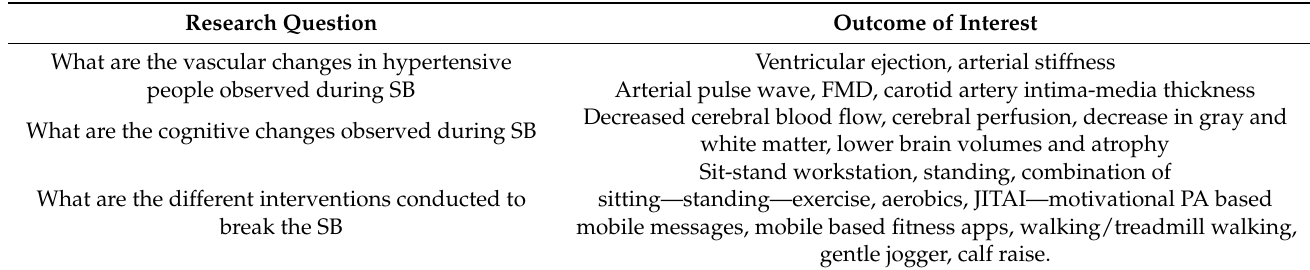
Table 1. Research questions and designated